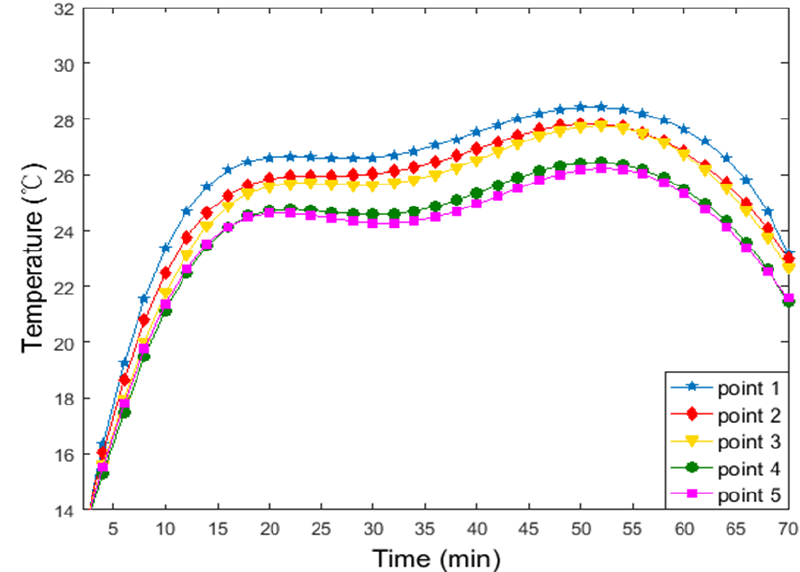
Figure 13. Temperature of each point in Experiment 2.